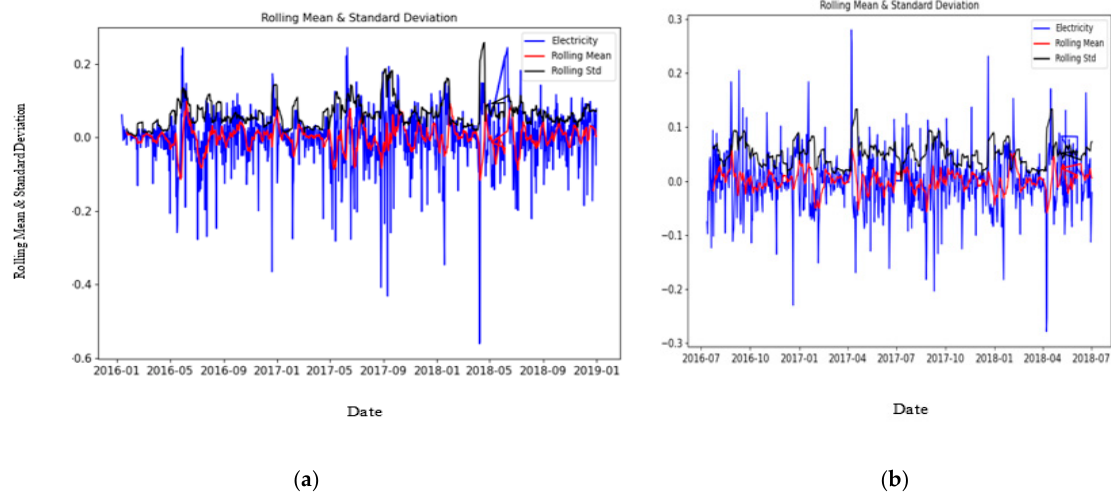
Figure 4. Test results: ( a ) pre − estimation, eliminating trend and seasonality; ( b ) post − estimation, eliminating trend and seasonality.